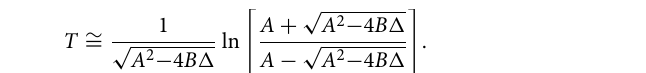
10 8 and m 3 Figure 5. Dynamics of the collapse in simulations of uncorrelated networks with N = = 0 and layers as a function of δ for a range of values of (cid:31) . The degree distribution distribution is P ( 0 ) = 1 / 2 1 ) δ . Notice that for this P ( q ) we have P ( q ) e − c c q − 1 /( q e − c for q > 0 , with c such that P ( 1 ) = − ! = = + F 1 ) < 0 at the critical point. ( a ) Total collapse time T for positive δ ; dashed lines represent Eq. (14). ( b ) ′′ ( Relaxation rate τ for negative δ . Each point is averaged over 10 realizations of the network and damage in ( a ) 6 are considerably noisier because the absolute 10 and over 100 realizations in ( b ). In panel ( b ) points for (cid:31) − = 10 2 , is already quite (cid:31) N number of edges removed, ∼ =